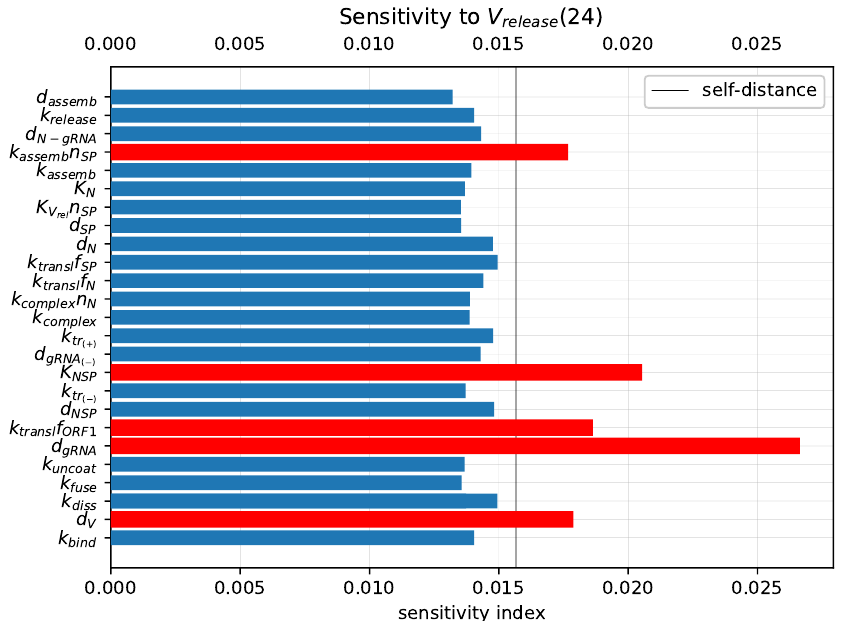
Figure 8. Local sensitivity indices for the number of released virions at 24 h computed with the stochastic model. The significant indices with greater values than the self-distance for the sets with baseline model parameters are marked by